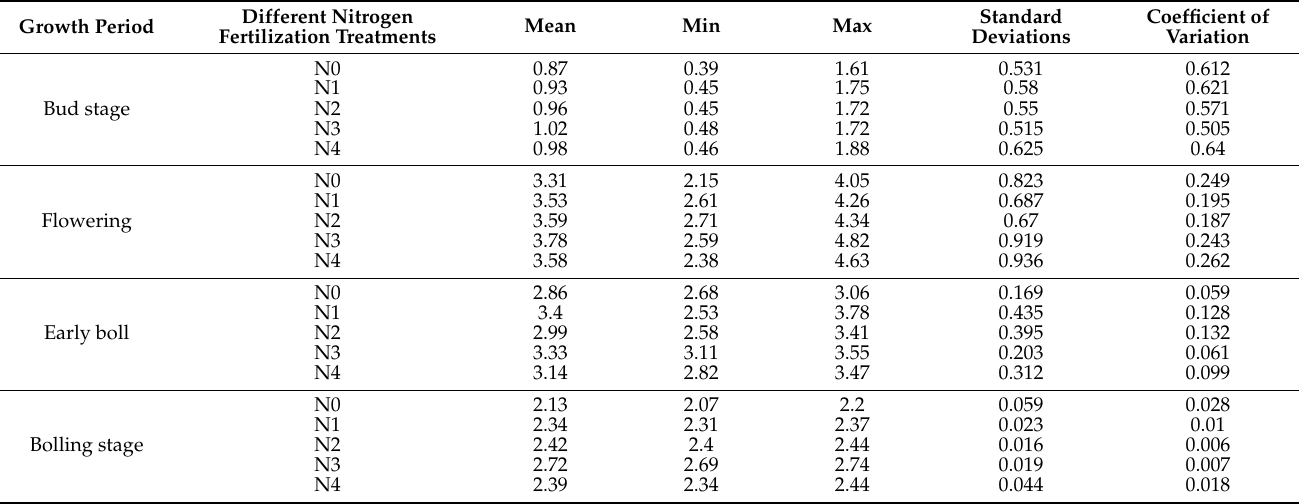
Table 2. Statistical analysis of cotton